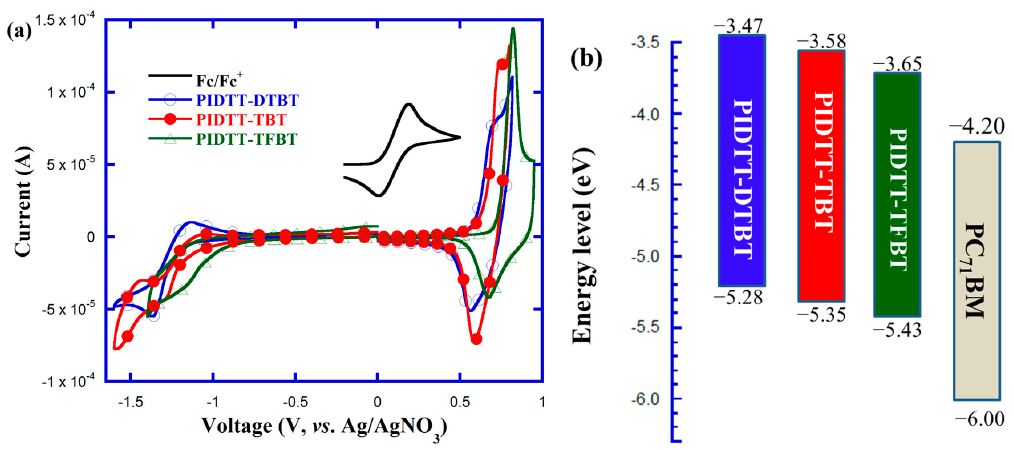
Figure 5. CV curves ( a ) and energy levels schematic diagram ( b ) of copolymers PIDTT-DTBT, PIDTT-TBT, and PIDTT-TFBT.